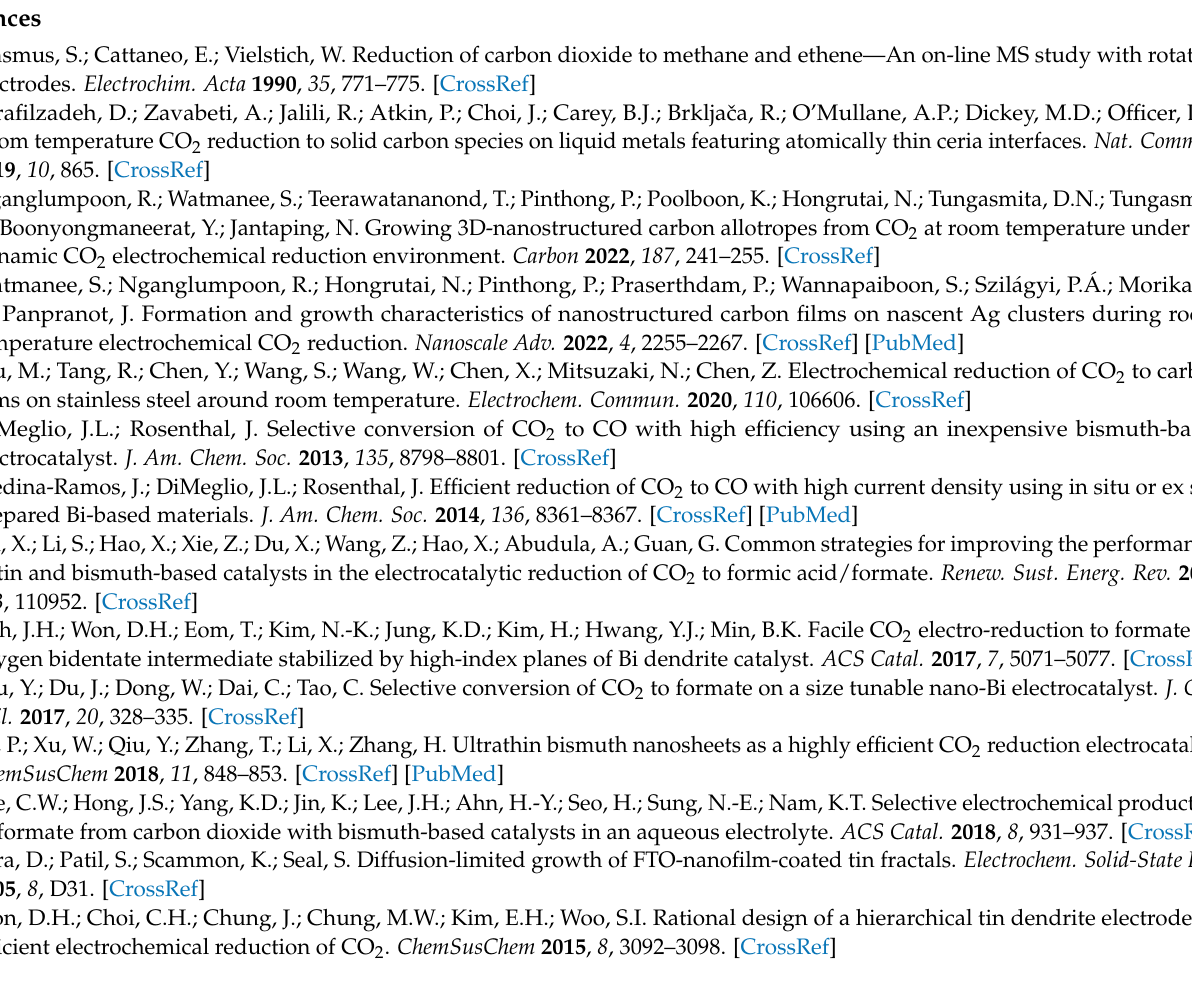
Figure S7: NMR spectra of catholyte results of 0.05Bi/Sn after CO 2 RR at − 1.7 V vs. Ag/AgCl for 70 min; Figure S8: Current density of Bi/Sn during CO 2 RR at − 1.1 V vs. Ag/AgCl for 70